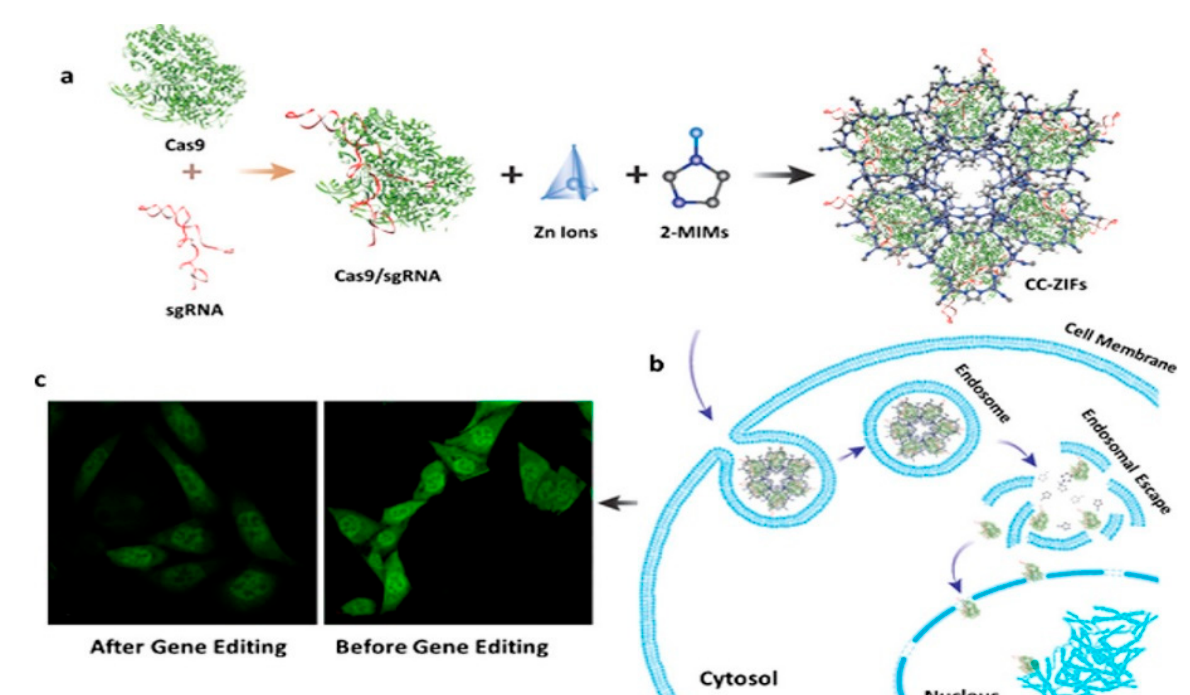
Figure 3. The gRNA/Cas9 complex assembled with the ZIF-8 metal–organic framework pores. The zif-8 was used to transfer CRISPR machinery to tumor cells efficiently. ( a ) Encapsulation of ZIF-8 nanoparticles. ( b ) Endosomal escape. ( c ) Image cell before and after treatment. Reprinted with permission from ref [35]. Copyright 2018, American Chemical Society.